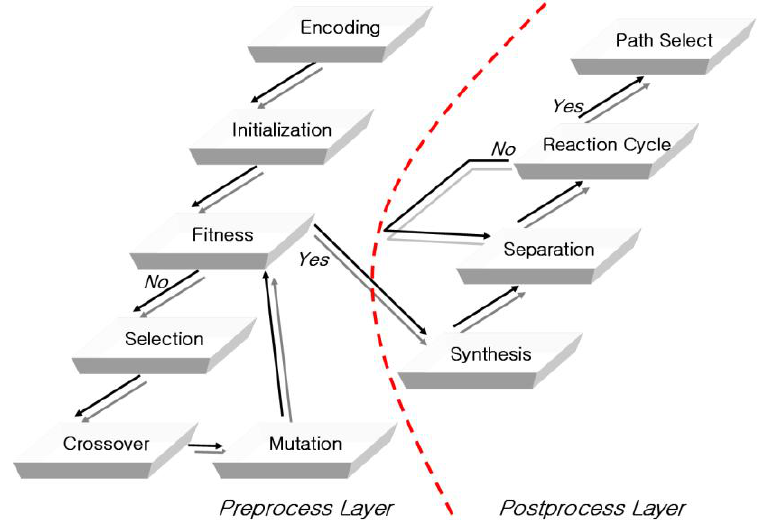
Figure 1. The flow of the recognition molecule receptor DNA sequence generation algorithm.